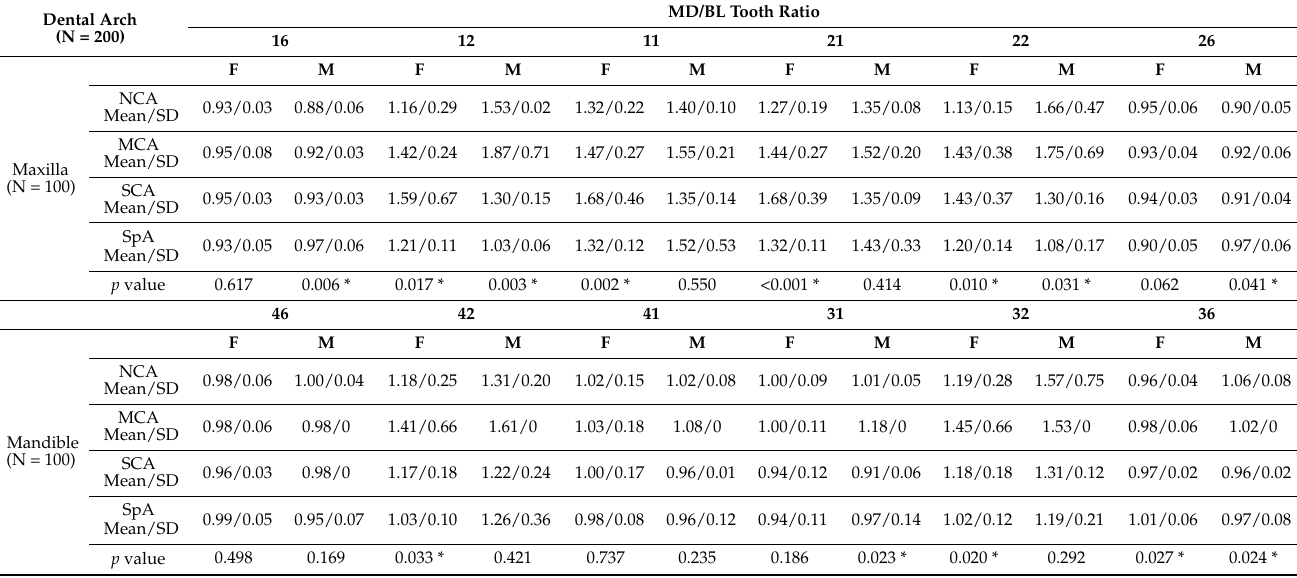
Crown proportions were different in normal, spaced, and crowded arches (Table 9). Upper incisors and lateral lower incisors presented statistically significantly larger crown proportions in arches with crowding than those in normal and spaced arches. Table 9. Comparison of crown proportions between normal, spaced, and crowded arches for female and male patients (statistical significance according to ANOVA analysis).